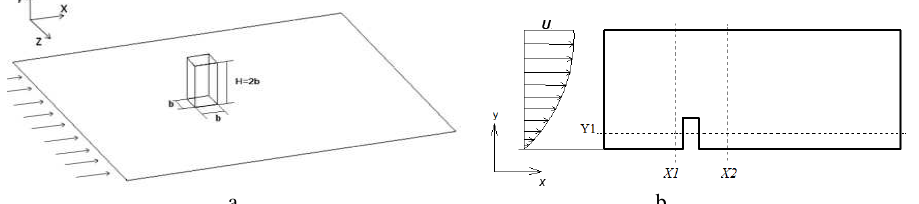
Fig. 1. The geometry of the problem ( а ) and the calculation domain in cross-sectional view (b).